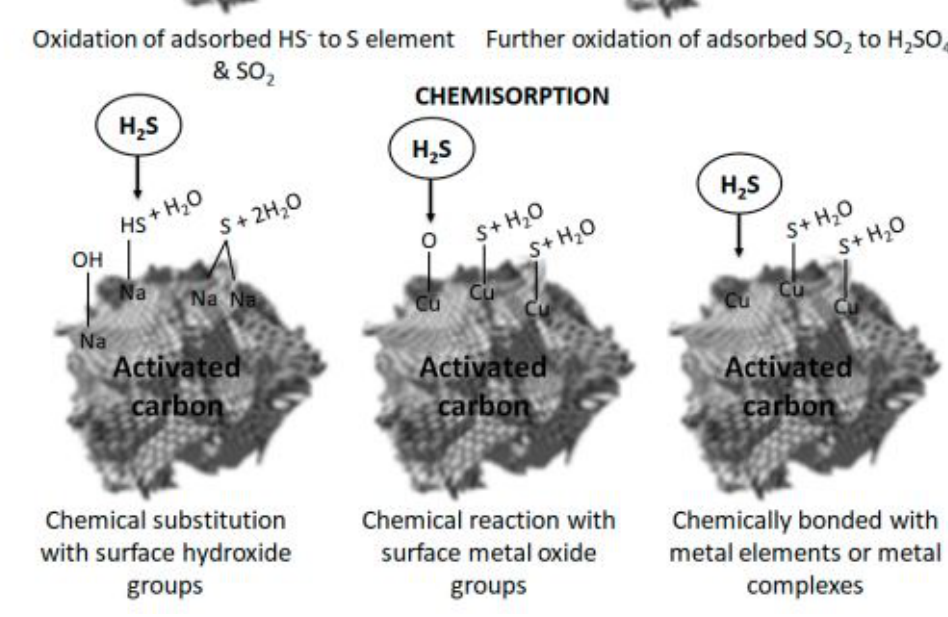
Fig. 1. Physical and chemical adsorption of H 2 S onto activated carbon [20]. NiO nps were synthesized by using alkaline precipita- tion method with some modifications [15]. A 4.65 g of